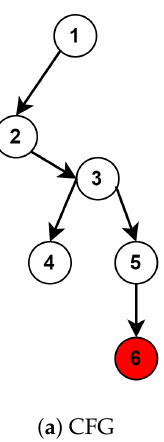
Figure 2. PDG extraction procedure of code listing 1.